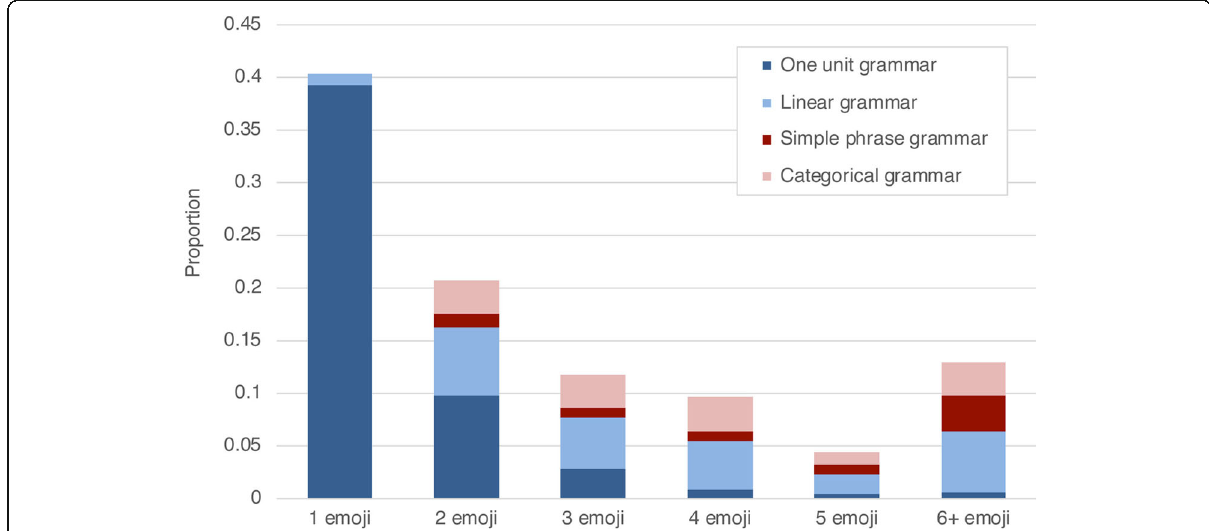
Fig. 1 Number of emoji used in emoji-only utterances and the types of sequencing complexity used in those utterances. Note that one-unit grammars could comprise more than one emoji (see Table